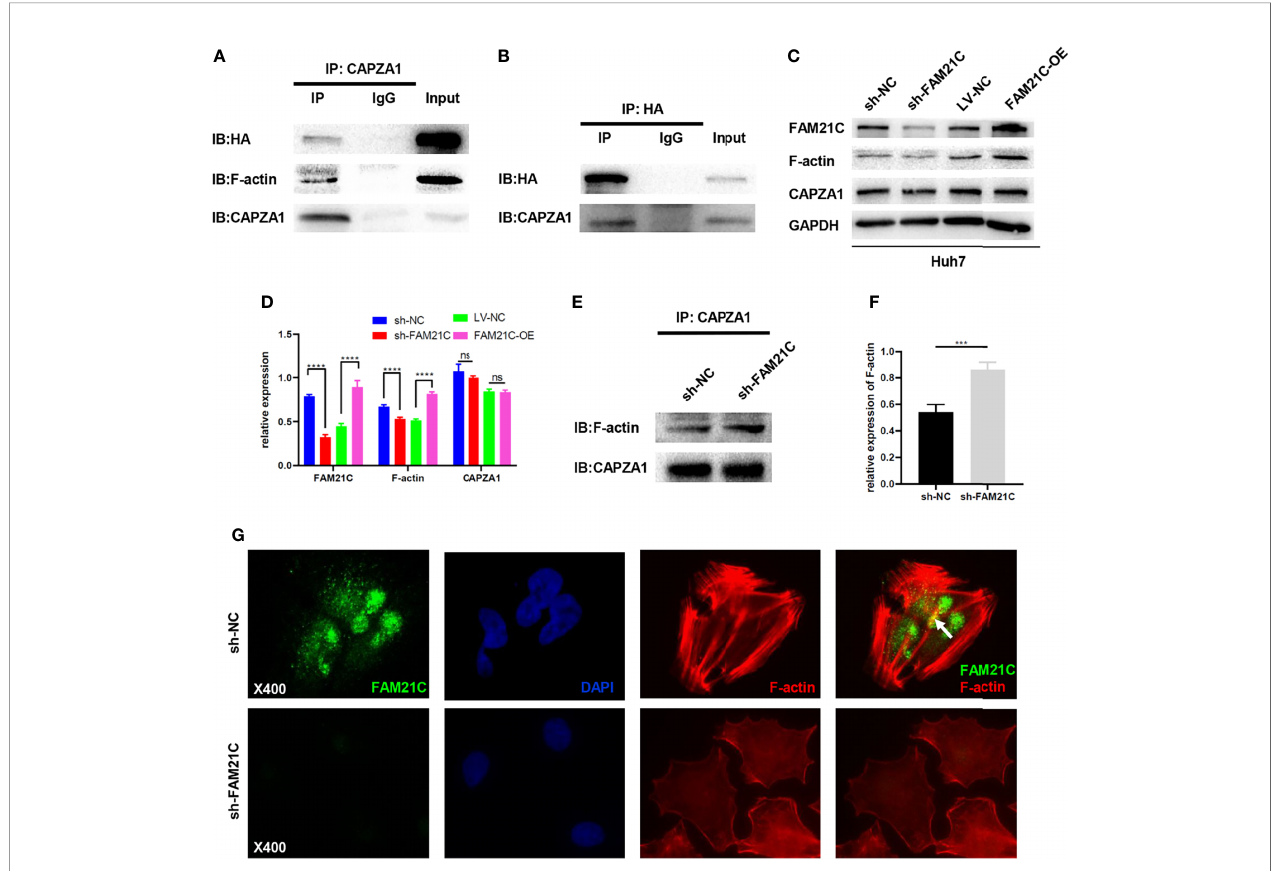
FIGURE 4 | FAM21C bind to CAPZA1 and inhibit the capping ability of CAPZA1 to promote cytoskeleton remodeling in HCC cells. (A, B) Co-Immunoprecipitation (Co-IP) was performed to validate protein interactions. The results showed that HA-FAM21C and CAPZA1 can pull each other down. Moreover, Co-IP also showed that CAPZA1 can interact with F-actin. (C) Western blotting was used to detect the expression of FAM21C, F-actin, and CAPZA1. GAPDH was used as the loading control. (D) Histograms show the relative expression. (E) Quantitative Co-Immunoprecipitation showed that the binding level of F-actin to CAPZA1 was increased after FAM21C knockdown. CAPZA1 level was considered loading control. (F) After Quanti fi cation by ImageJ software, the histograms showed the relative level of F- actin. (G) Immuno fl uorescence assay on Huh7 cells showed that with the decreased of FAM21C, actin cytoskeleton scattered arrangement, and lack of the colocalization of FAM21C and F-actin. (The arrowhead shows the colocalization). Nuclei were stained with DAPI. Scale bar = 400×. Data are represented as the mean ± SD, n=3. *** P < 0.001, **** P < 0.0001; ns for no signi fi